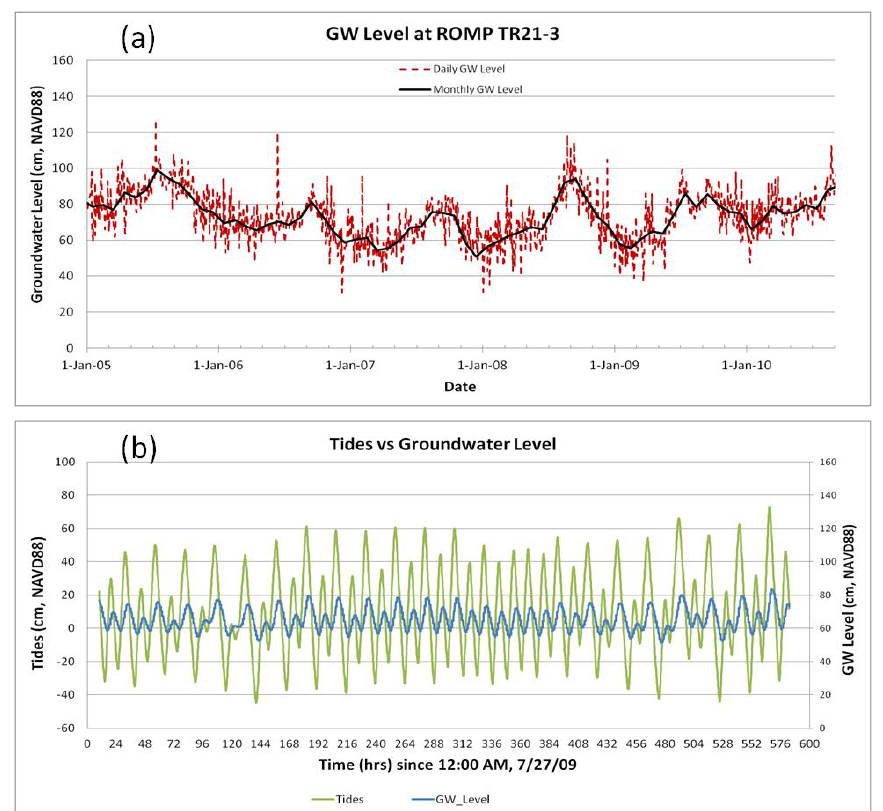
Figure 4. ( a ) Measured monthly and daily groundwater levels in ROMP TR21-3 during 1 January 2005–1 September 2010. ( b ) Comparison of measured Kings Bay tides and hourly groundwater level in ROMP TR21-3 during the 25-day continuous recordings of cross-sectional fluxes at G1 and